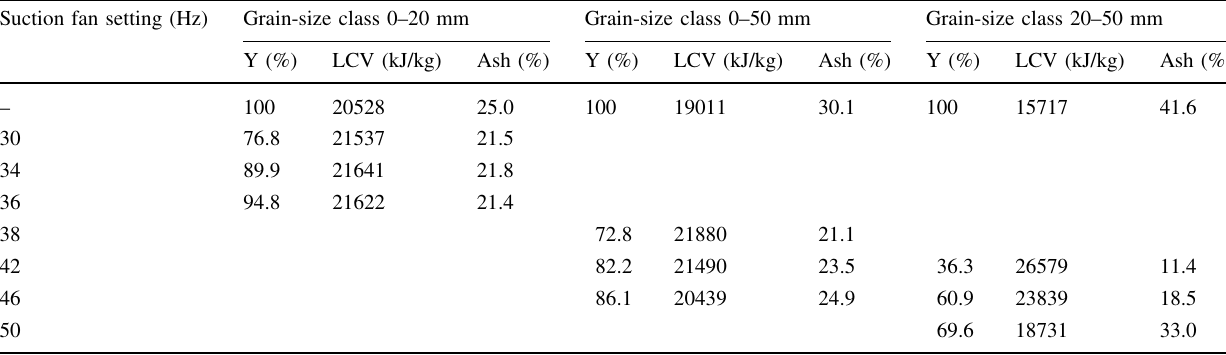
Table 10 Output yield (Y), LCV, and ash content of the sucked fraction, for feed material No. 1 Suction fan setting